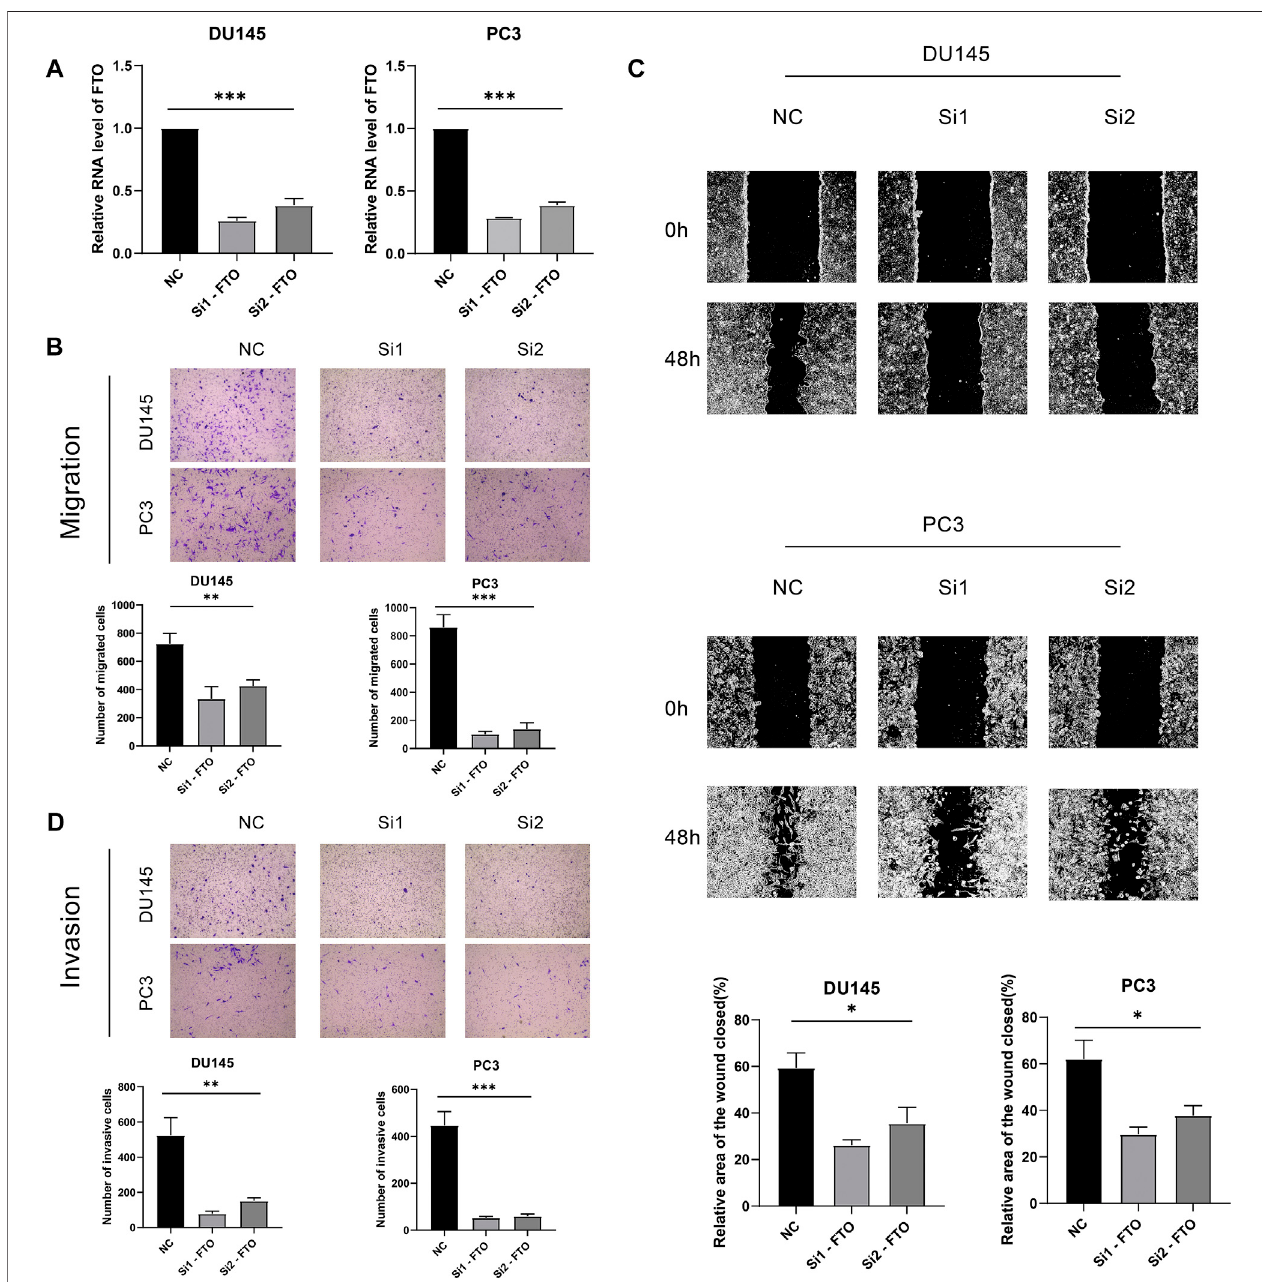
FIGURE 8 | (A) Vitro experiments. (B) Transwell assay. (C) Wound-healing assay. (D) Transwell assay with